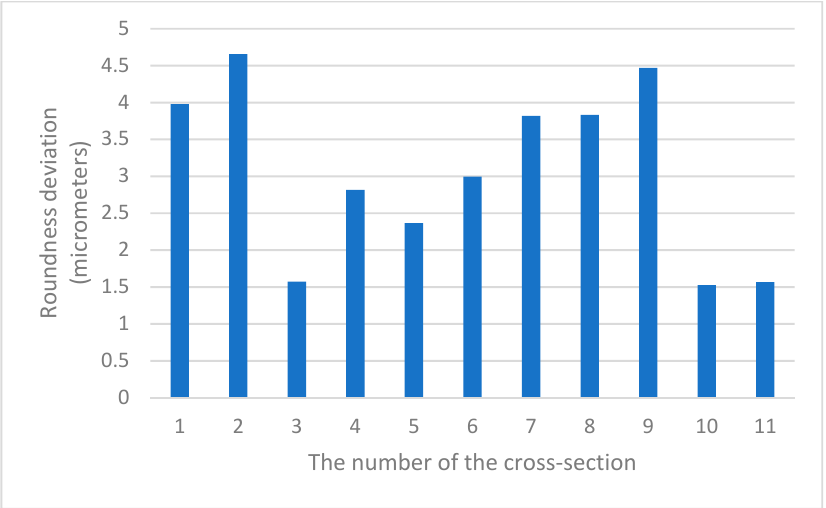
The number of the cross-section Figure 10. Values of roundness deviations in subsequent cross-sections of sphere no. 3 from the Figure 10. Valuesofroundnessdeviationsinsubsequentcross-sectionsofsphereno. 3fromthefirstdataset. first dataset.